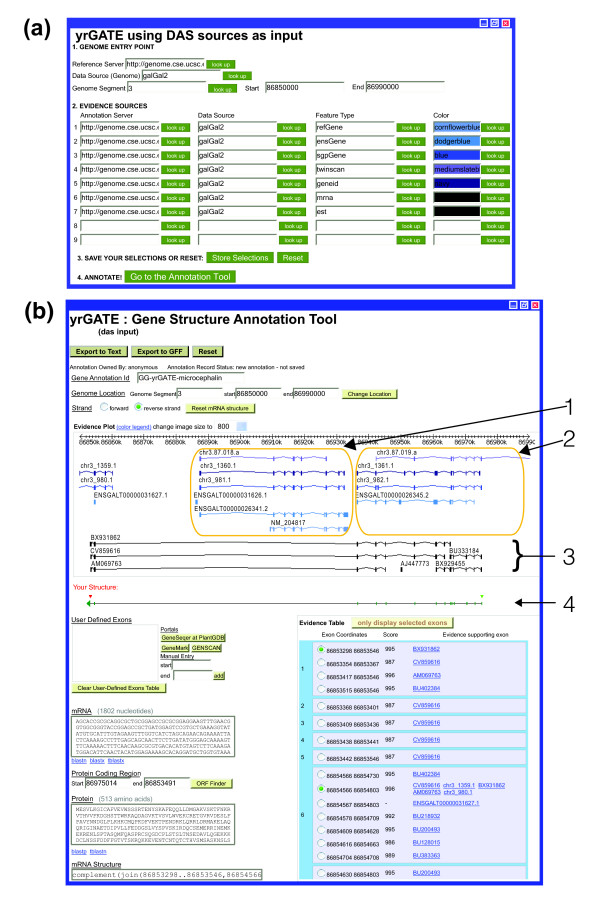
yrGATE with DAS input implementation. (a) The entrance to yrGATE is a selection page where a genome and associated evidence sources are specified. Chicken chromosome 3 region 86850000-86990000 is selected. (b) EST and mRNA are primary evidence sources (3). Additionally, secondary evidence sources of published annotations are selected for comparison including RefSeq, Ensembl, Twinscan, SGP, and Geneid genes. The novel annotation, GG-yrGATE-microcephalin, is based on EST and mRNA evidence and is distinct from all published chicken annotations in this region on this strand (2). This novel annotation (4) contains a known angiopoietin gene, NM_204817 (1), on the opposite strand within its 12th intron.